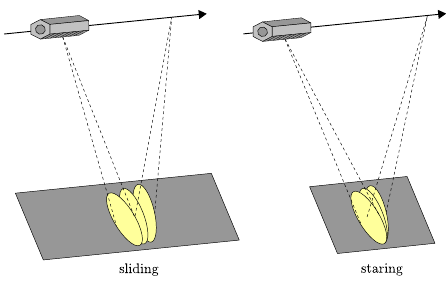
Figure 4. TerraSAR-X sliding ( left ) and staring ( right ) spotlight imaging geometry